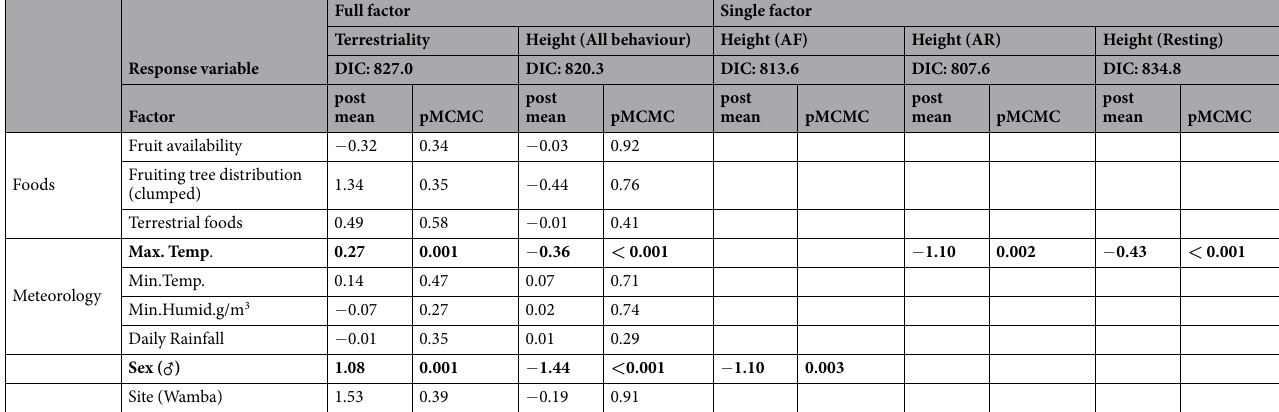
Table 2. Results of MCMCglmm for terrestriality and utilization heights. Full factor models were chosen for the analysis of “Terrestriality” and “Height of all behaviour”. Other three analysis for utilization heights were shown as single factor models.